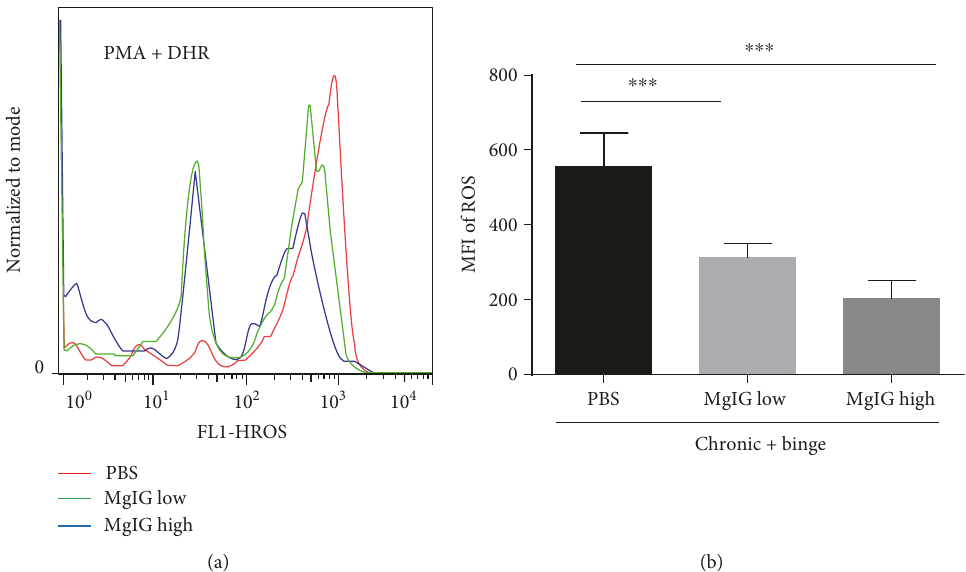
Figure 4: MgIG prevents chronic plus binge ethanol feeding-induced reactive oxygen species (ROS) production increase by liver neutrophils. (a) Liver neutrophils were isolated and stimulated with phorbol 12-myristate 13-acetate (PMA). ROS production was determined by dihydrorhodamine 123 (DHR 123) assay. (b) MFI of ROS was quanti fi ed. Values represent means ± SEM. ∗∗∗ p < 0 001 .